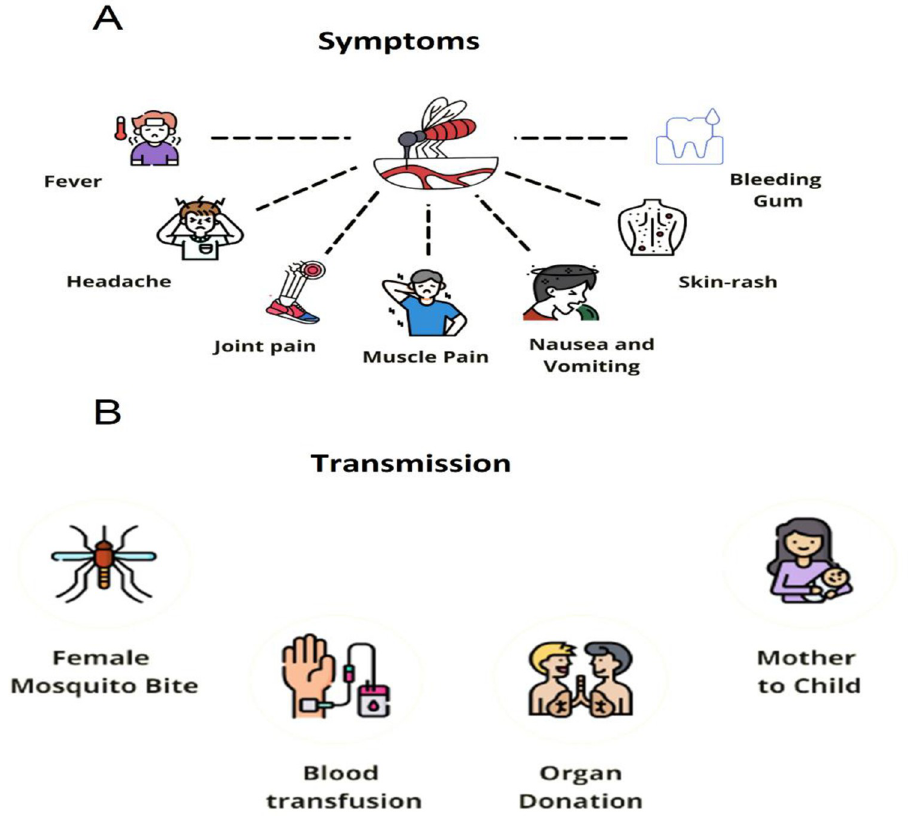
Fig 1. Different symptoms and transmission patterns of dengue